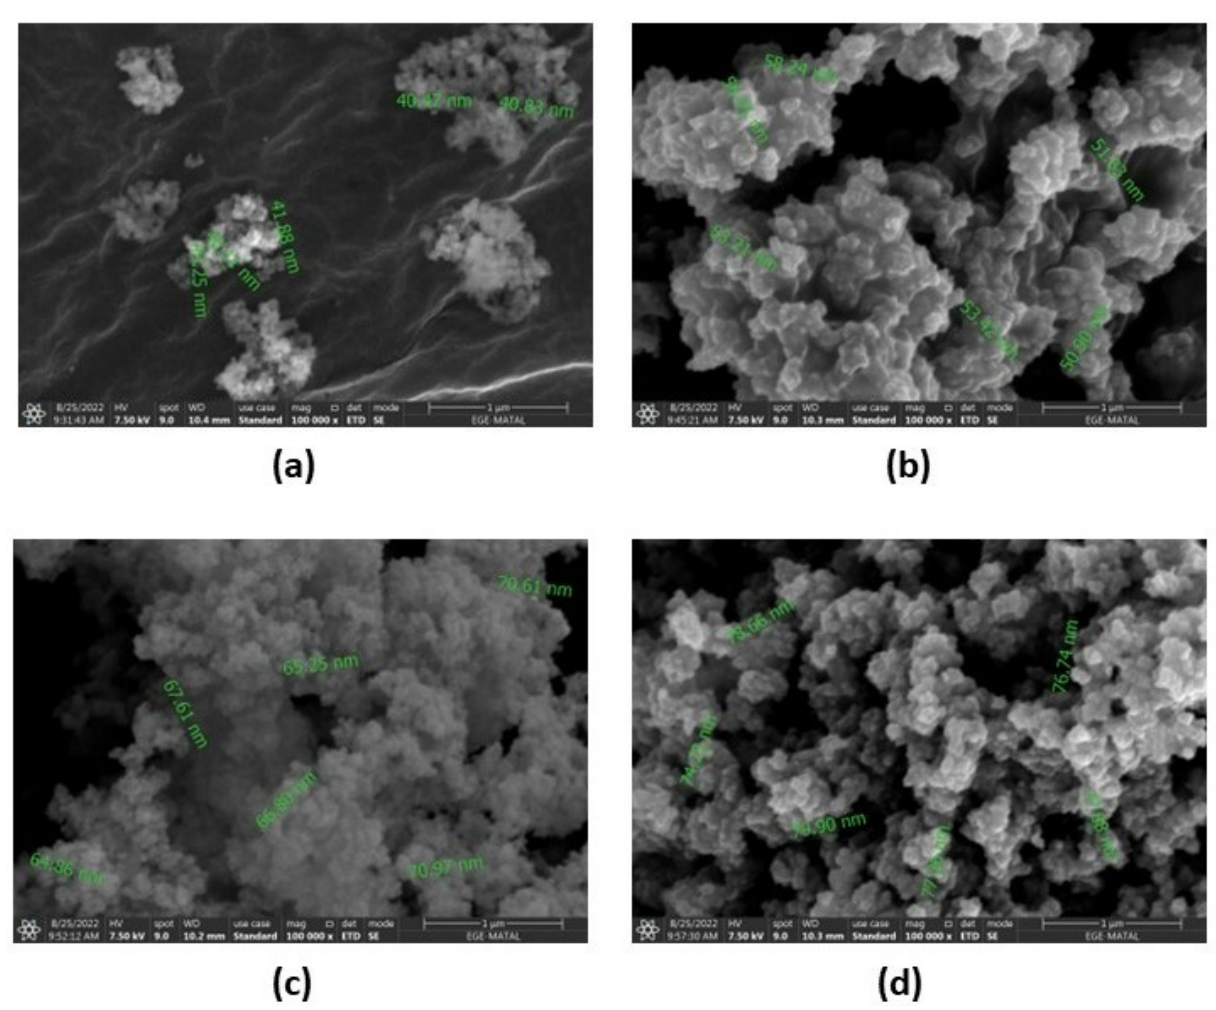
Figure 1. SEM images for ( a ) MNP, ( b ) MNP/TEOS, ( c ) MNP/TEOS/APTES, ( d ) MNP/TEOS/APTES/EDC/NHS/5-mC Ab. Table 1. Zeta potential and size measurement results for each modification steps of MNP.